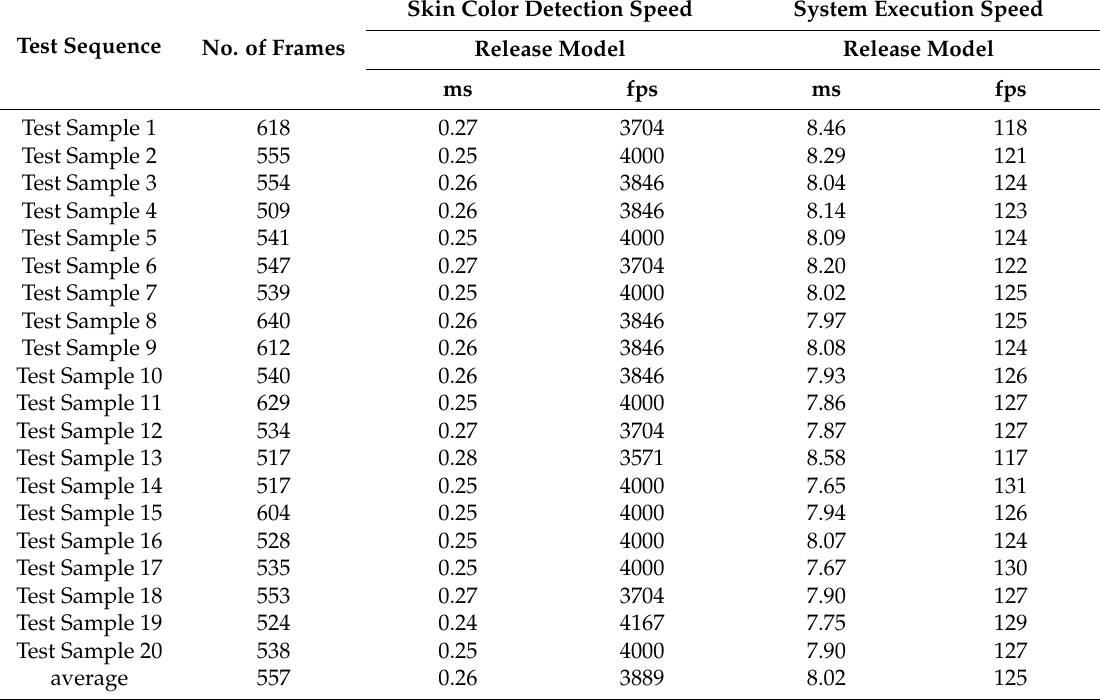
Table 4. Experimental data of skin color detection speed and system execution